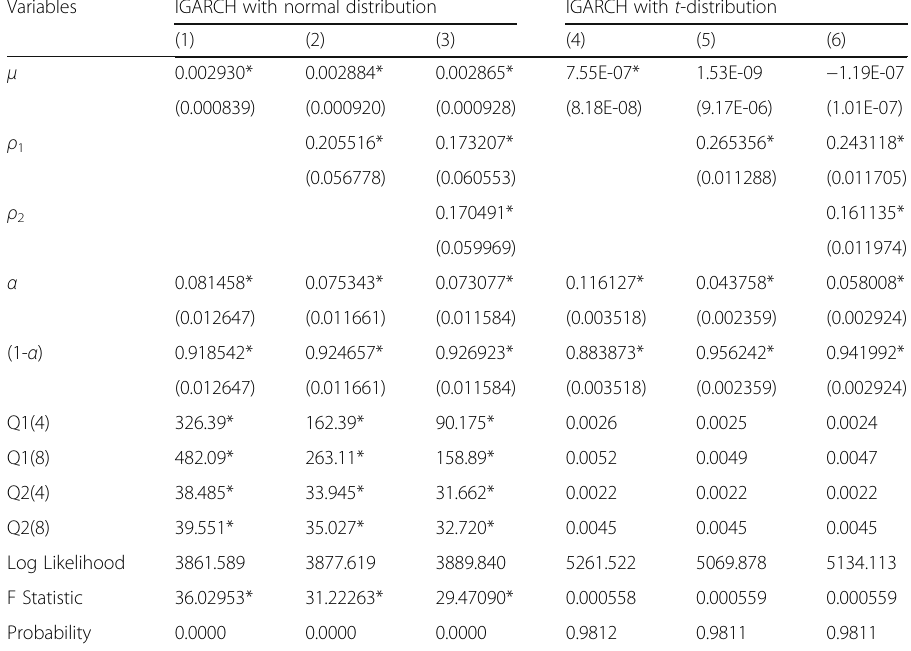
Table 6 Estimation results for IGARCH model